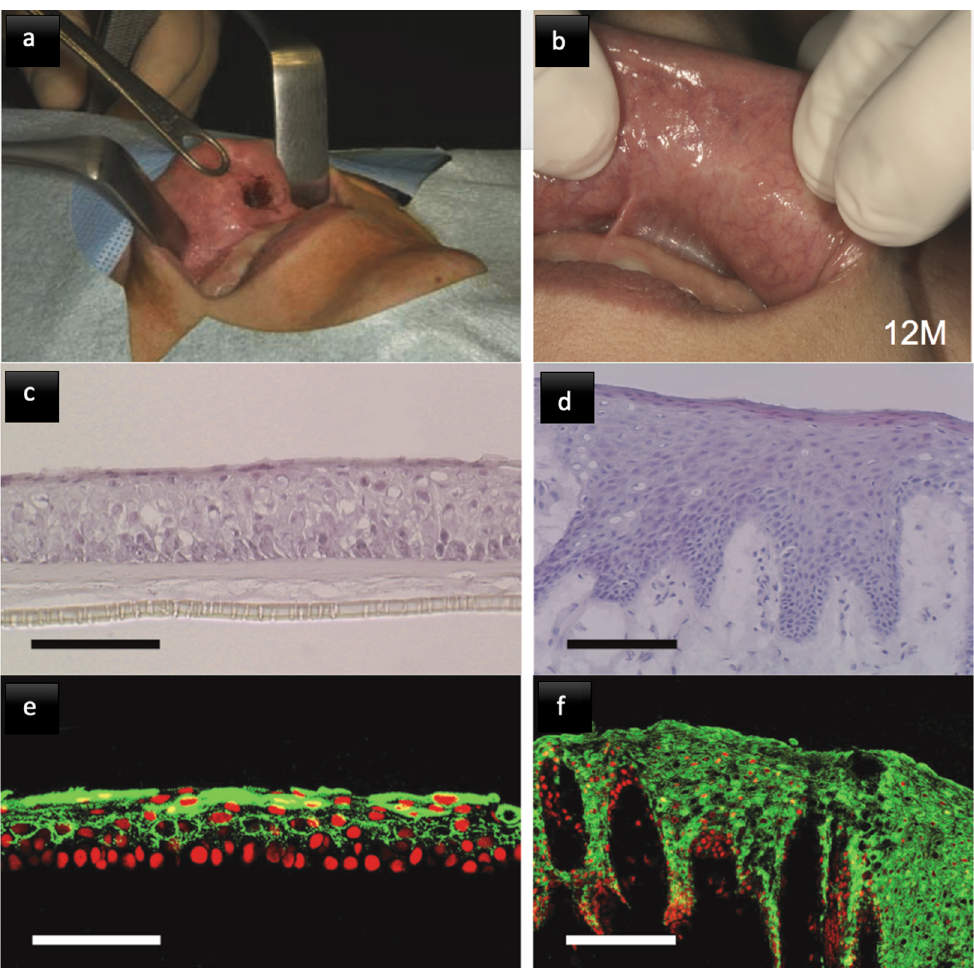
Figure 6. ( a,b ) Auto transplantation procedure for an oral mucosal defect for pleomorphic adenoma at the time of surgery and 12 months after surgery, respectively; ( c–f ) morphology and keratin expression patterns of amniotic membrane-cultured oral mucosal cells and oral mucosa; haematoxylin and eosin stained mucosal epithelial cells exhibiting seven differentiated and stratified layers ( c ) as compared to oral mucosa in vivo ( d ); keratins (green) expressed in the cultured mucosal cells ( e ) vs. oral mucosa ( f ); and nuclei stained with propidium iodide (red). Scale bars: ( c , e ) 100 μ m and ( d , f ) 200 μ m. Images derived from Amemiya et al. [236].